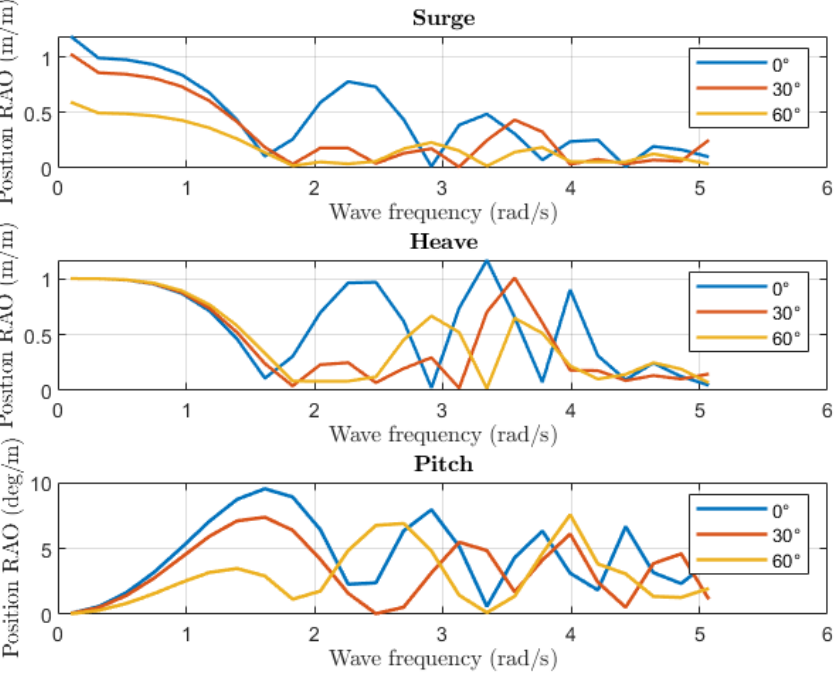
Figure 11. RAOs along surge, heave and